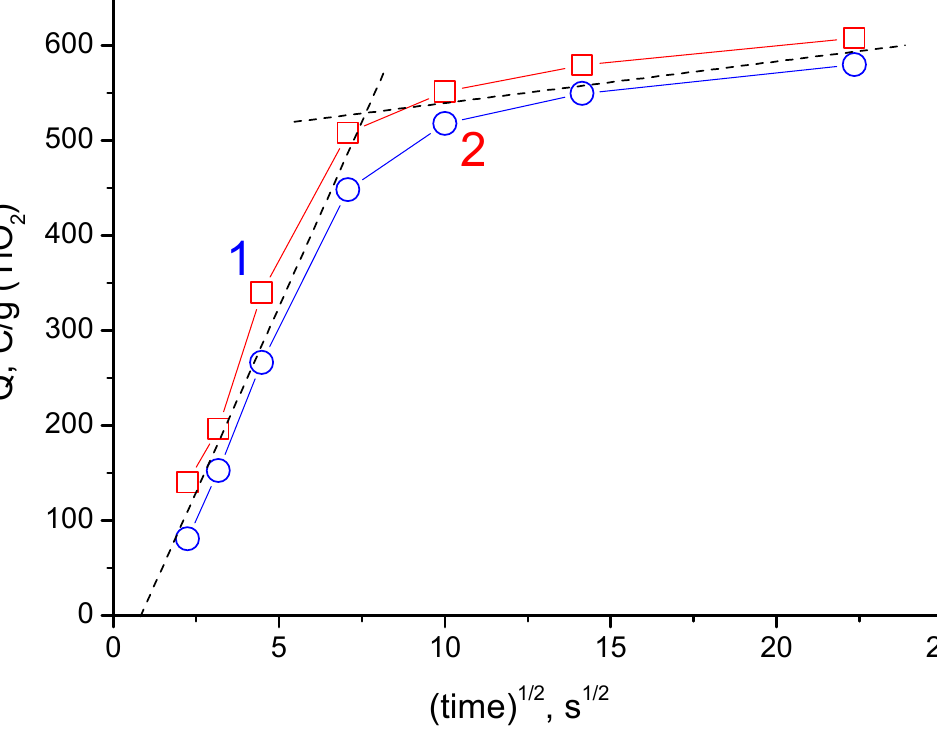
Figure 10. Dependence of pseudocapacitance, which was obtained from the data of galvanostatic discharging (see Figure 8) and recalculated per mass unit of TiO 2 , on the square root of charging time. 1—rGO/TiO 2 15%; 2—rGO/TiO 2 30%.